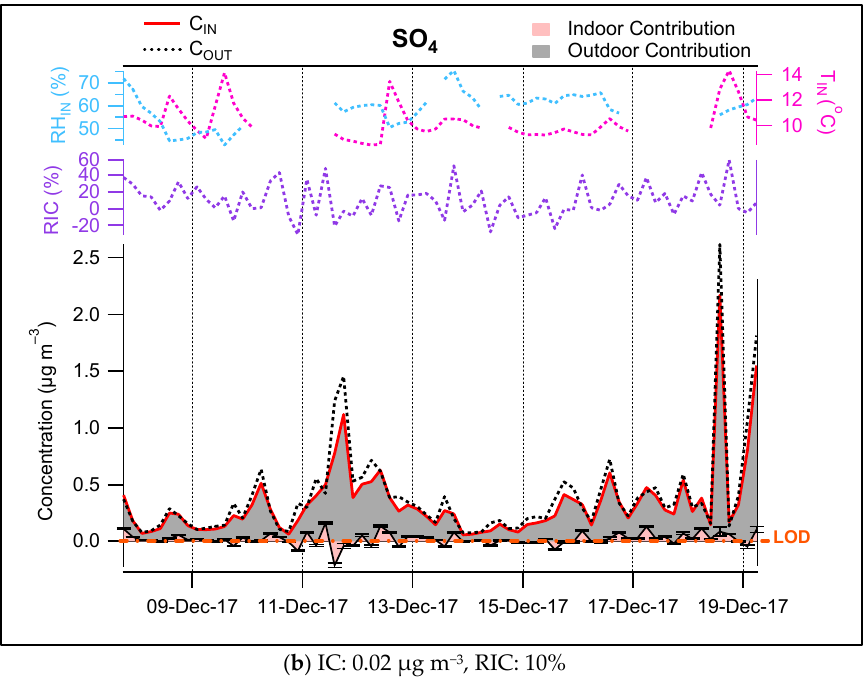
Figure 10. ( a ) Scatter plot of indoor-outdoor concentrations color-coded by date for NR-PM 1 SO 4 , ( b ) IC-OC contribution. Error bars represent 1 σ .